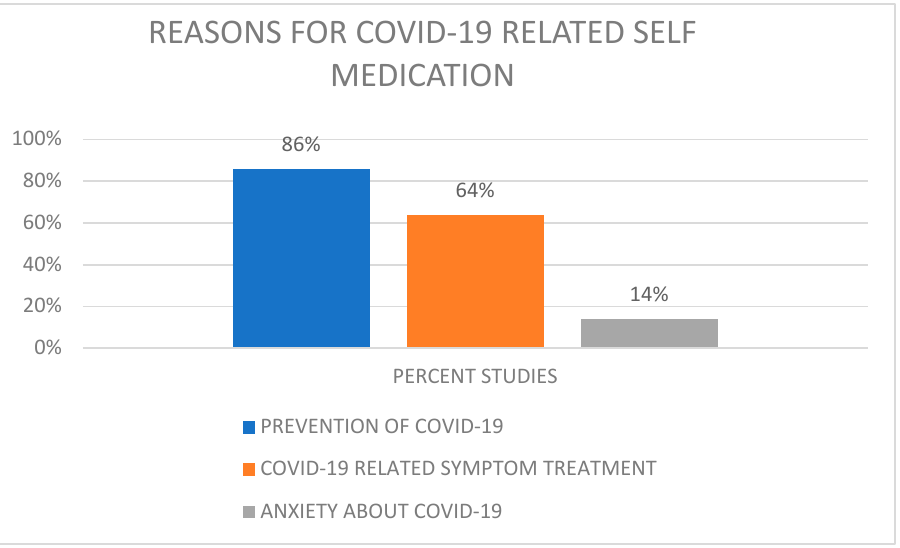
Figure 4. Reasons for self-medication by number of studies.